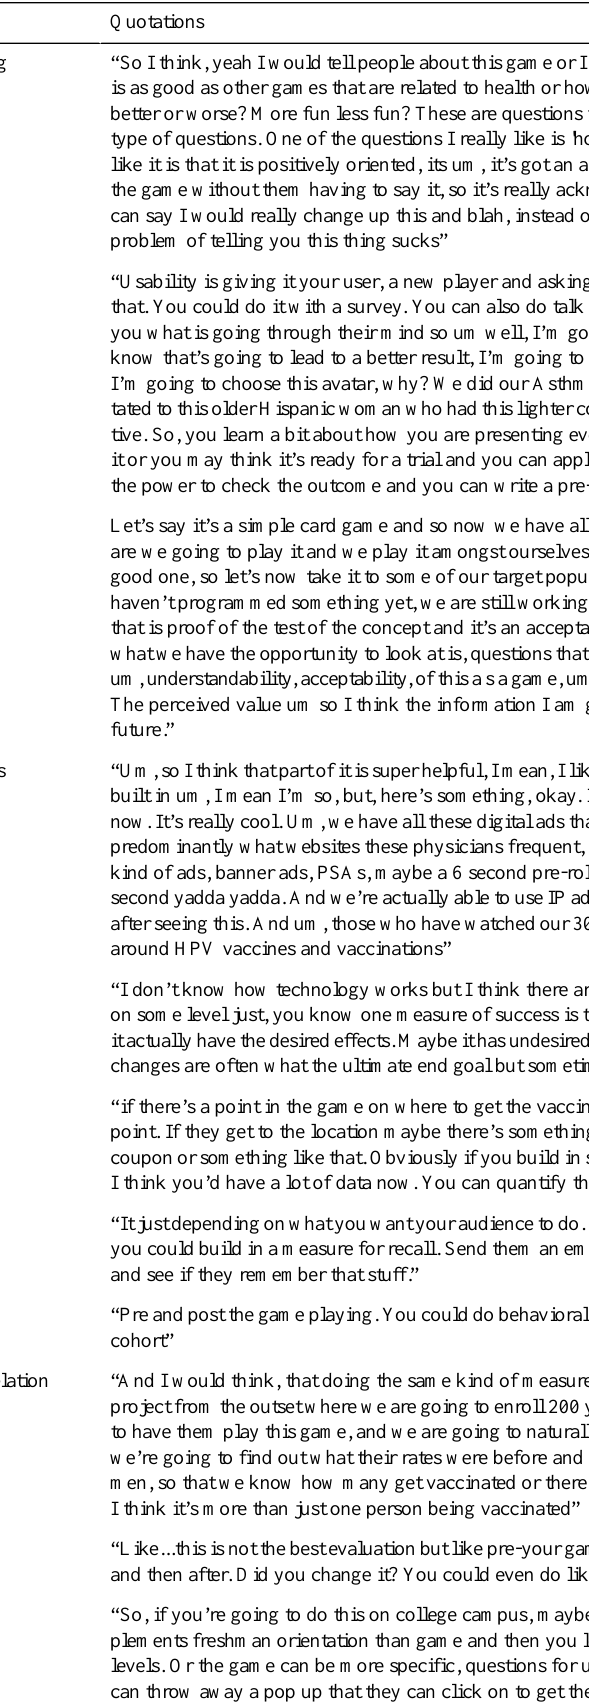
Table 3. Evaluation for quality and impact outcomes